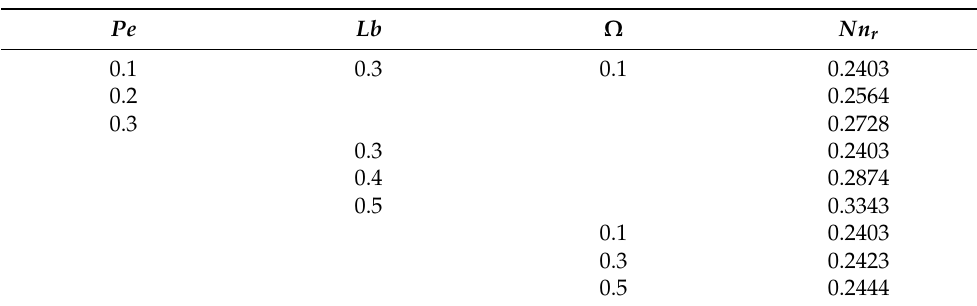
Table 6. Effect of various physical parameters over density of motile microorganism Re